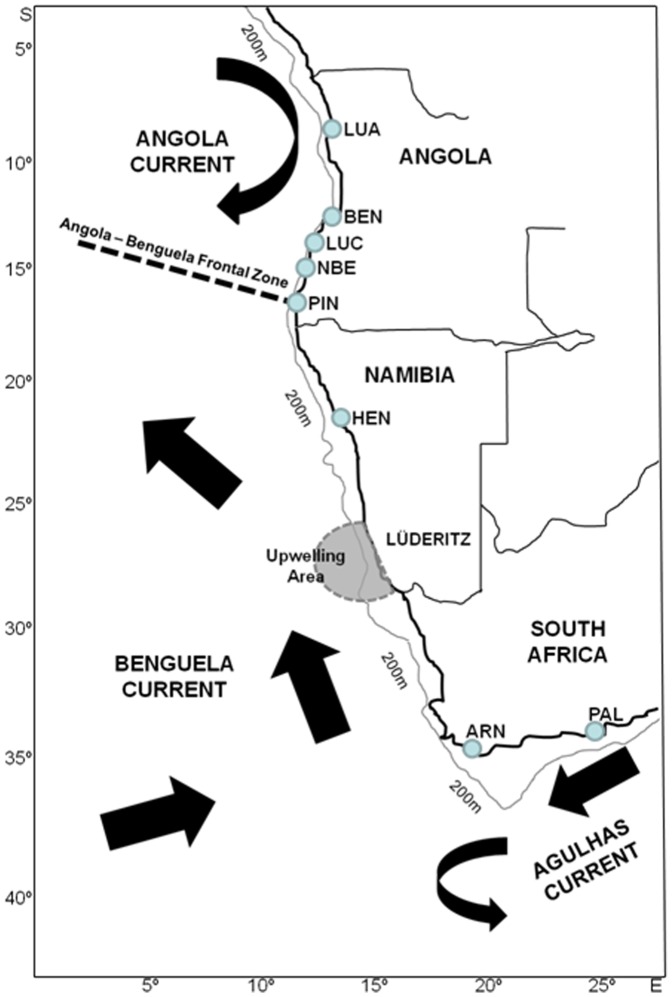
Oceanographic regions sampled.Sampling strategy for A. aequidens across the Benguela Current region, highlighting sampling sites (see Table 1 for sampling codes), and their position relative to the major oceanographic features of the system: position of the Benguela and Agulhas Currents, central Namibia upwelling cell, and continental platform width.